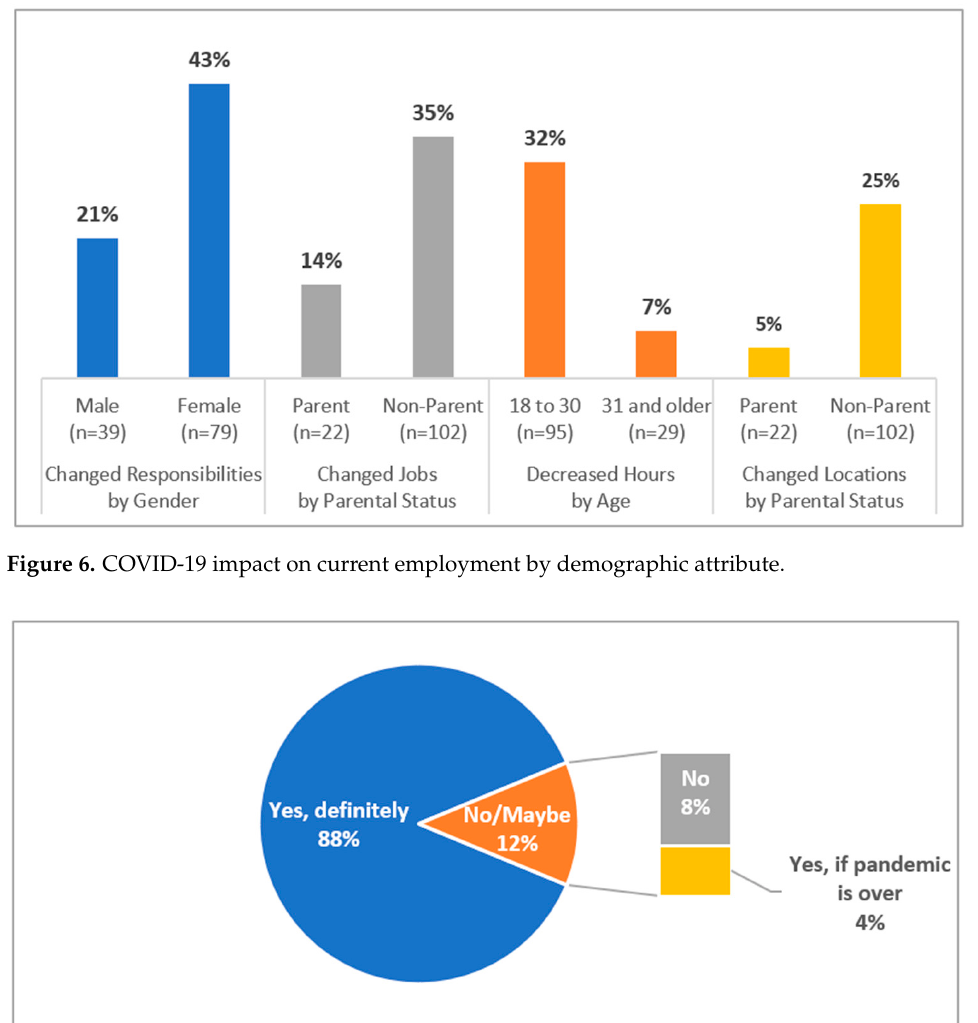
Figure 7. Planned employment over summer/fall ( n = 160).